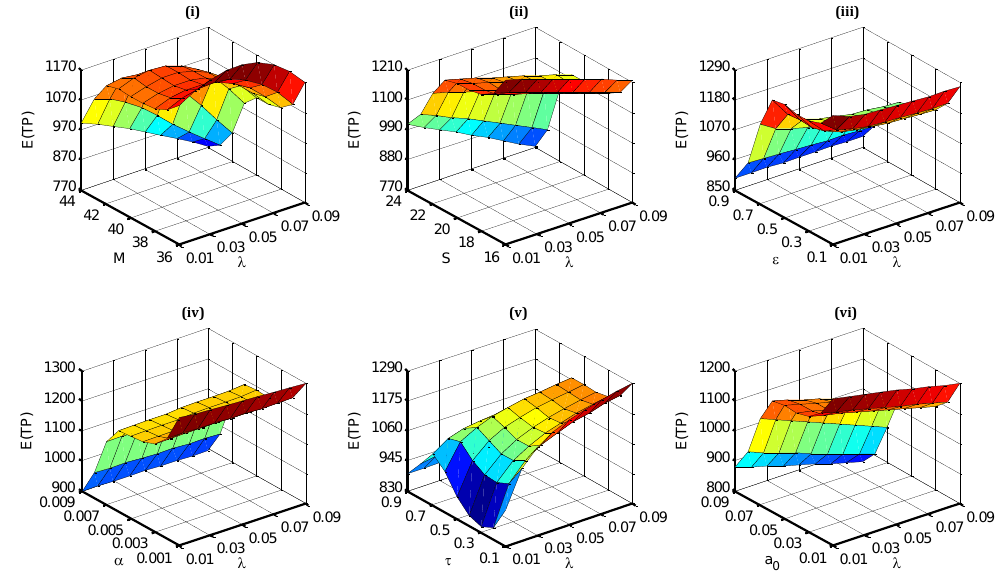
Figure 6. The expected total profit of the system ( ) TPE wrt the failure rate of the operating machines ( )  .